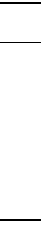
Table 3. LogP values determined for all the tested porphyrins by the shake-flask